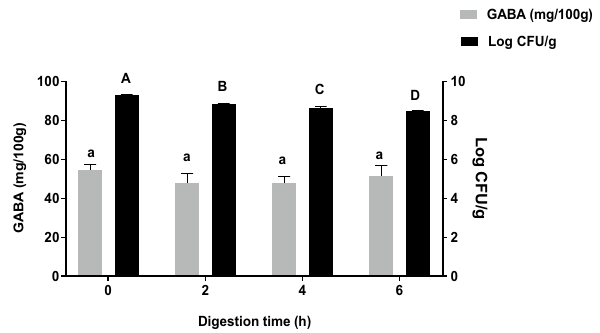
Figure 2. Effect of simulated digestion on GABA content and viable cell count in GABA-rich yoghurt. Different letters indicate significant difference ( p < 0.05) for GABA content (small letters) and viable cell count (capital letters) during 6 h of simulated